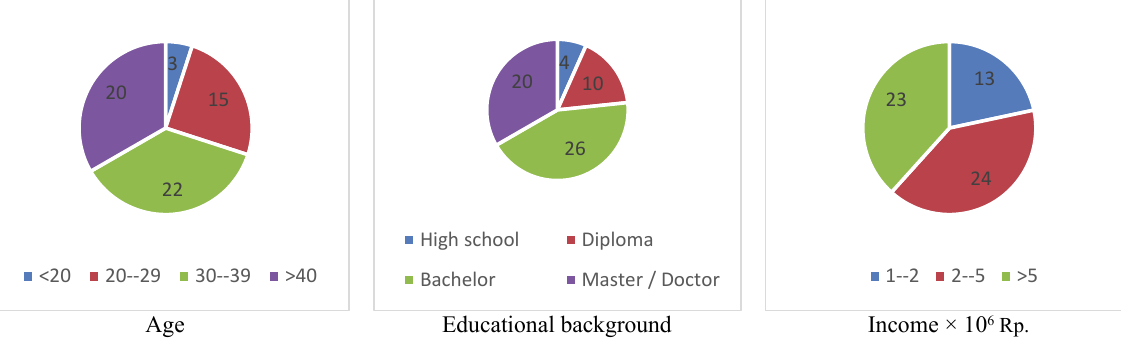
Fig. 2. Personal characteristics of the participants